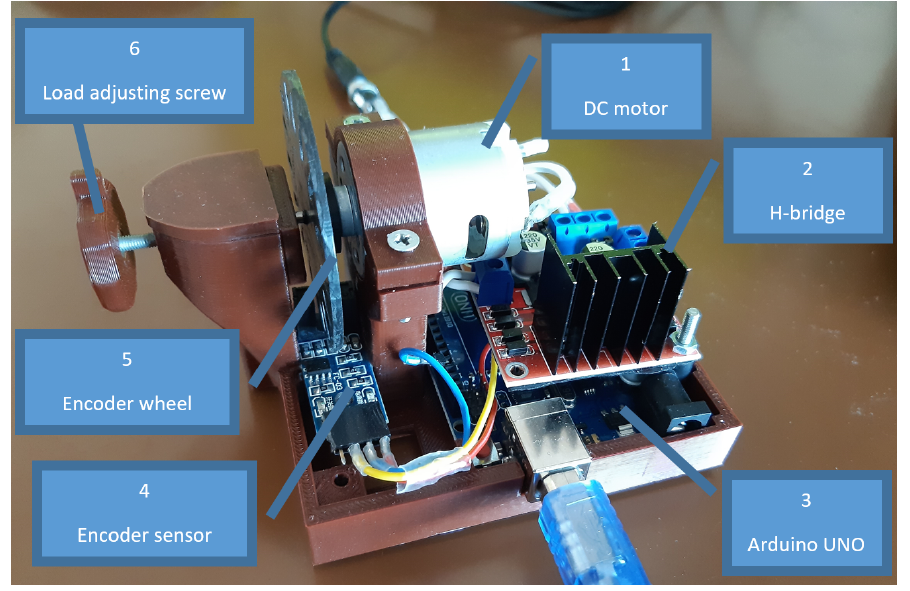
Figure 4. DC motor laboratory